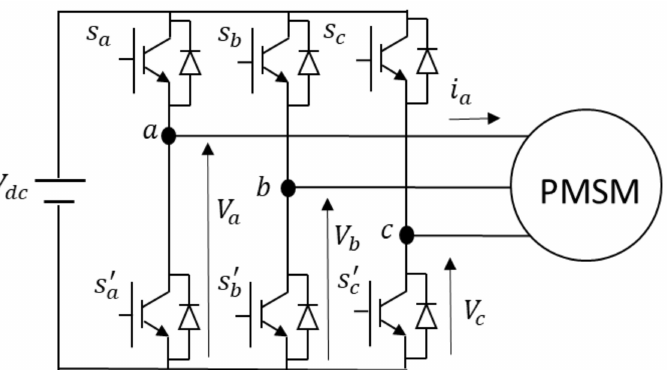
Figure 1. Three-phase voltage source inverter (VSI)-fed permanent magnet synchronous motor (PMSM).